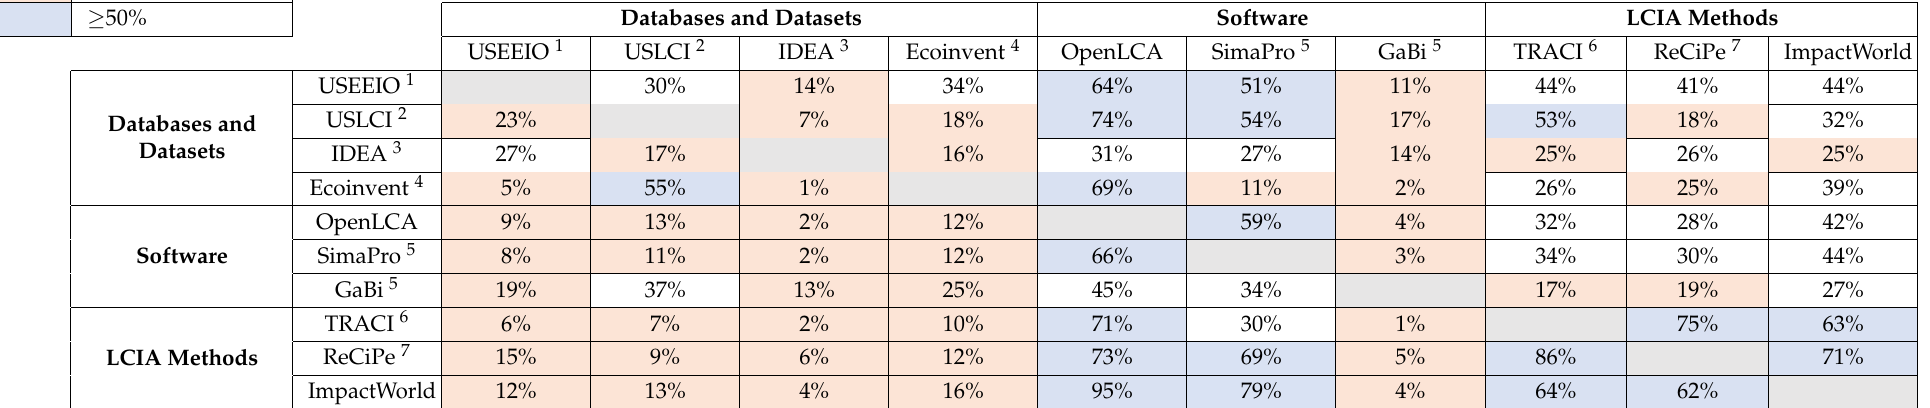
Table 5. Comparison of interoperability between LCA